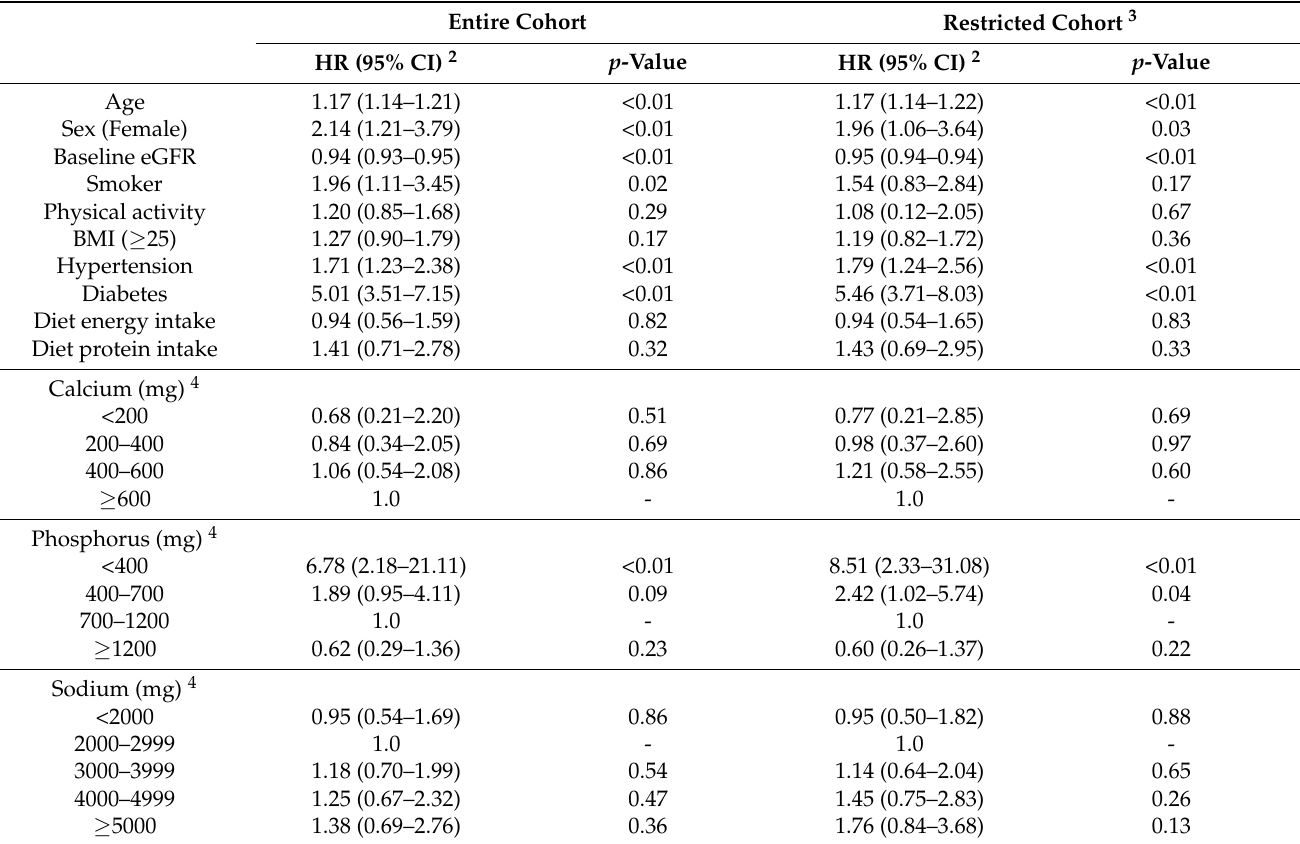
Table 2. Micronutrients and CKD 1 risk stage 3B and over in the full multivariable model (clinico-nutritional model) 2 controlling multiple nutrients and additional risk